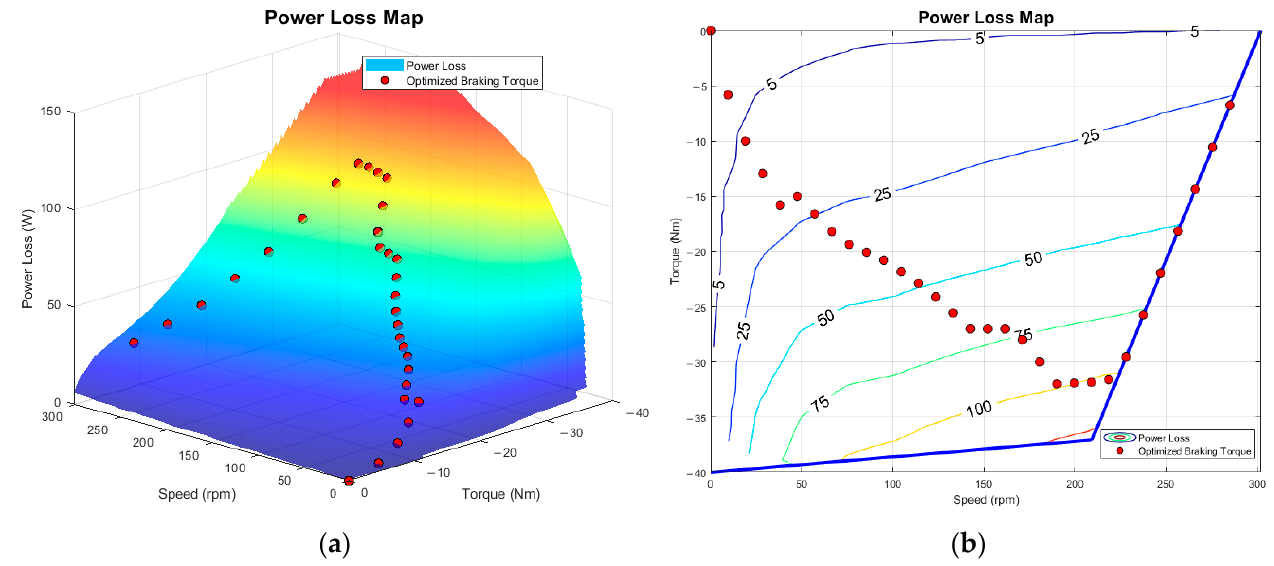
Figure 6. The measured power-loss map of the investigated powertrain with the optimized braking torque function: ( a ) 3D power-loss map; ( b ) contour plot of power loss.